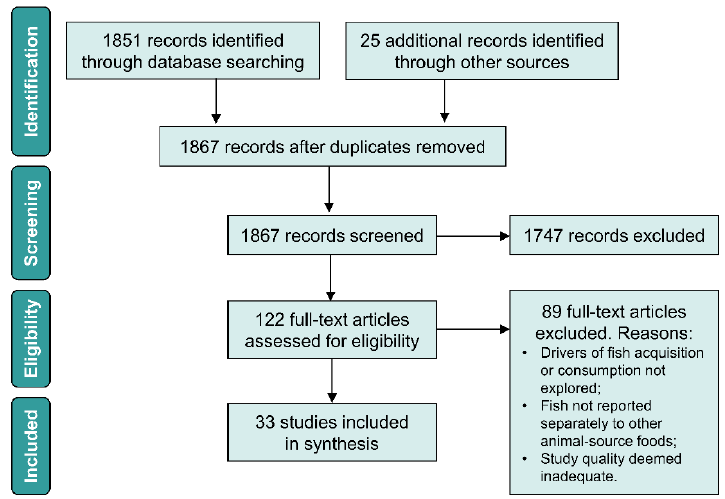
Figure 2. Studies reviewed and excluded at each stage.